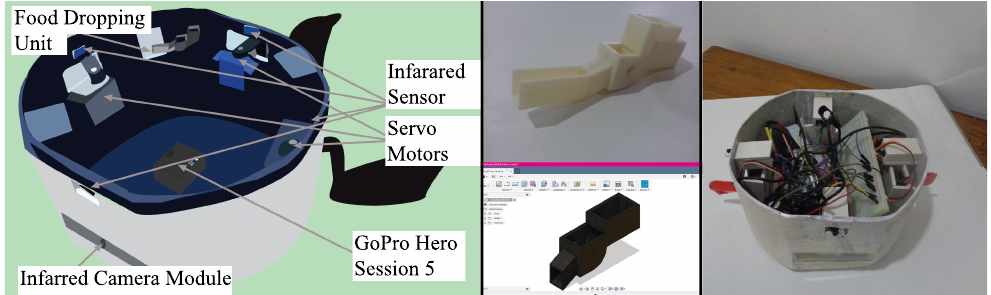
Figure 2. From left to right. ( Left ) Illustration of the 3D model of the robot with sensors. ( Middle ) 3D printed fish dropping unit and its 3D design. ( Right ) Sensors are put into the robot in the initial stage of development.